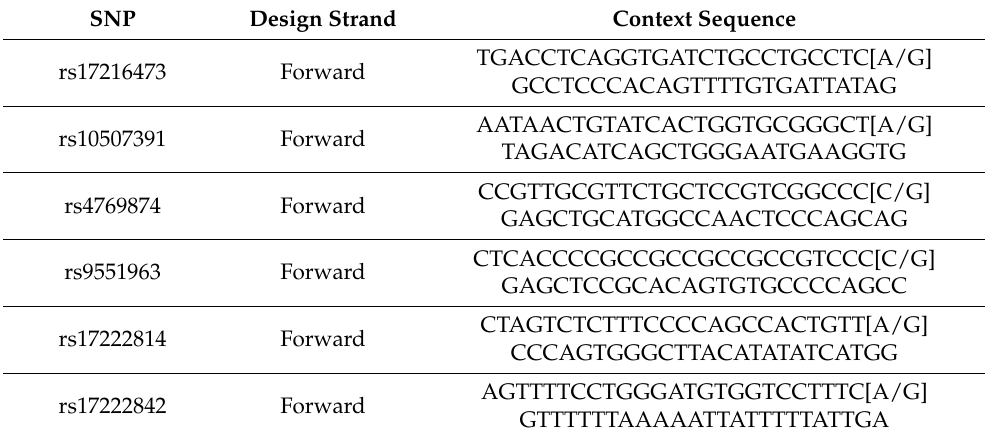
Table 1. Primers used for PCR amplification and pyrosequencing of regions of the human ALOX5AP gene. SNP Design